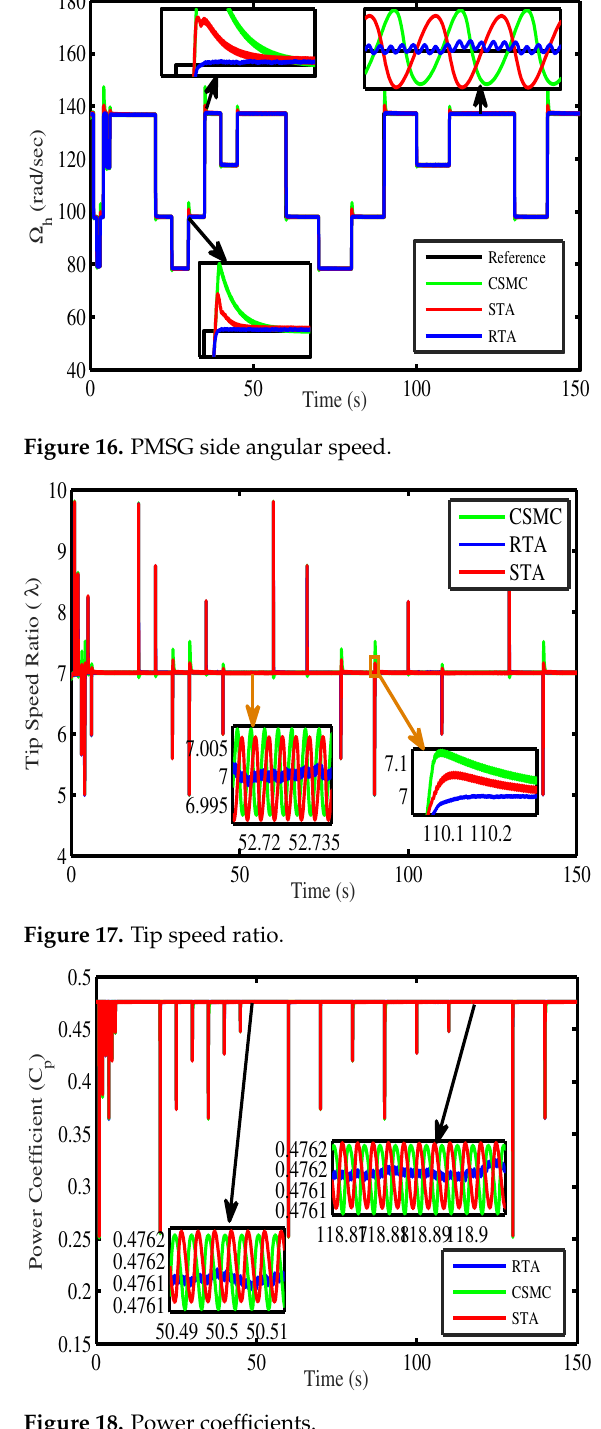
Figure 18. Power